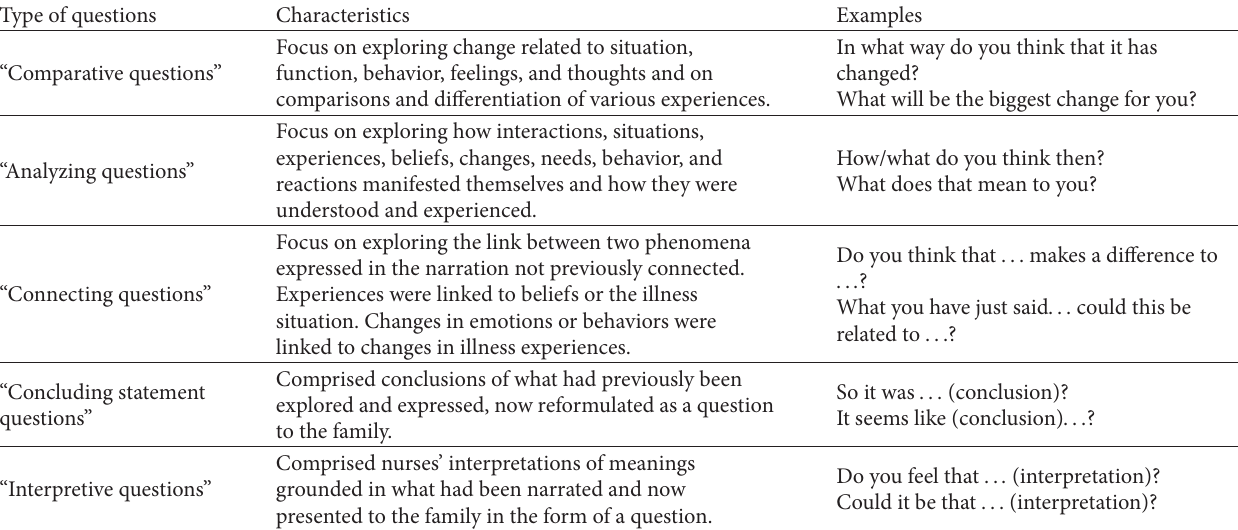
Table 4: Categorization, characteristics, and examples of questions asked by conversational leaders in the exploring